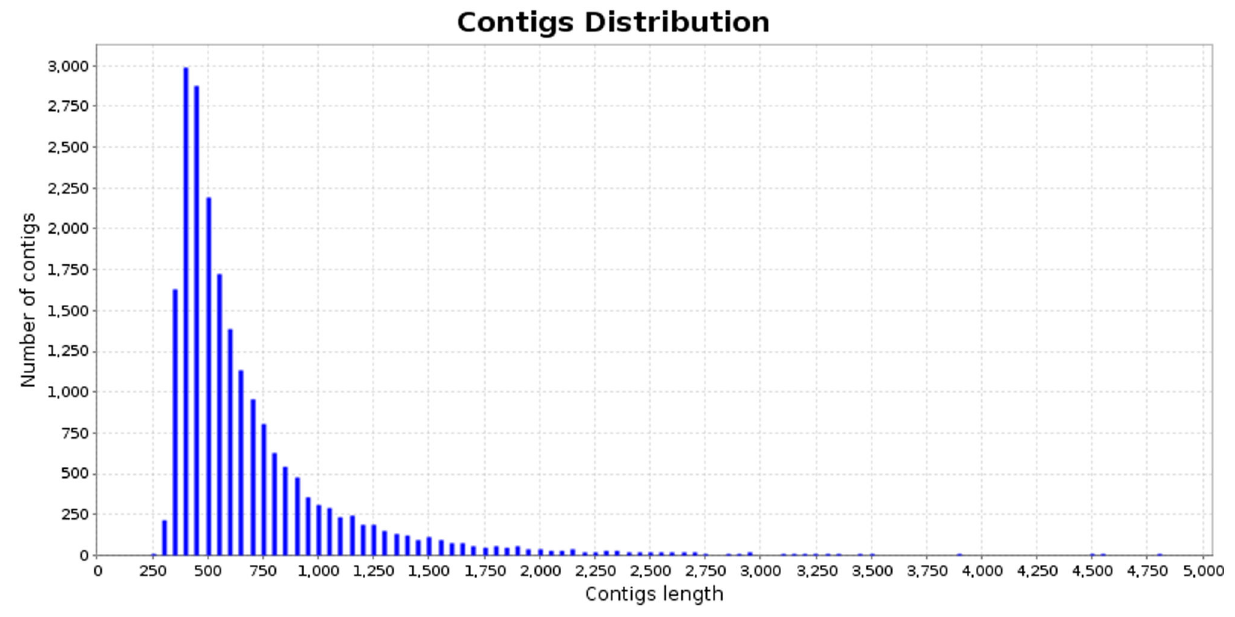
Figure 1. Contigs length distribution showing the major number ranging from 350 to 1000 pb. The average contig length was